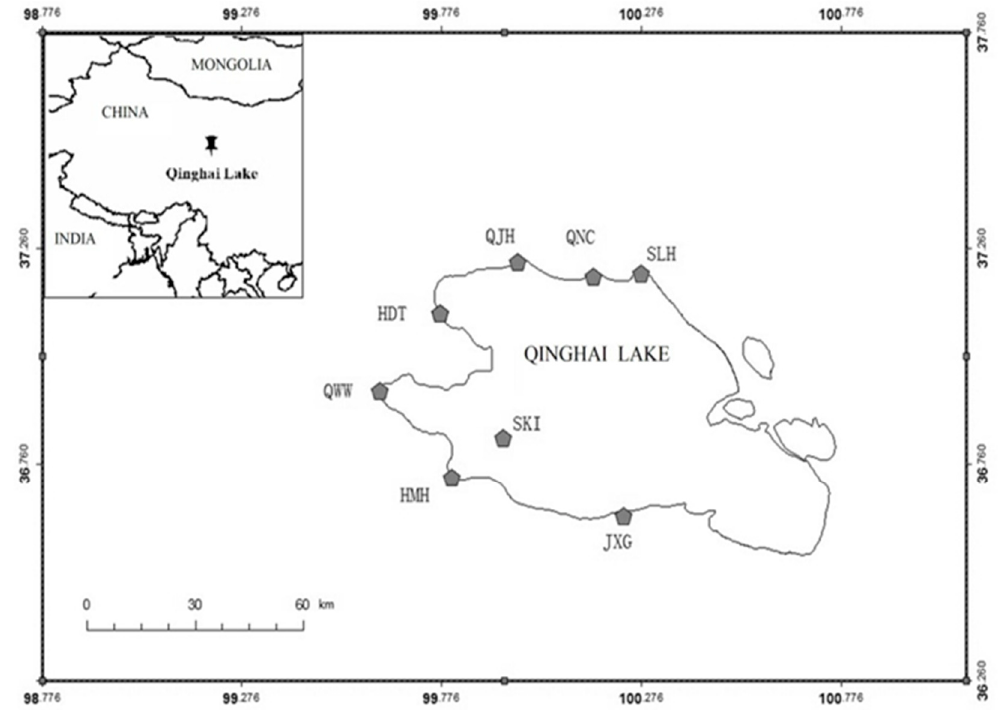
Figure 1. Map of Qinghai Lake in China 37.625 ◦ N, 98.772 ◦ E, 36.255 ◦ N, 101.011 ◦ E), where Bar-headed Geese (Anser indicus) were tracked by satellite telemetry during the breeding season. Wetland site codes are JXG (Jiangxigou), HMH (Heimahe Estuary), SKI (Sankuaishi Island), QWW (Quanwan), HDT (Hadatan), QJH (Quanjihe Estuary), QNC (Nongchang), and SLH (Shaliuhe Estuary).